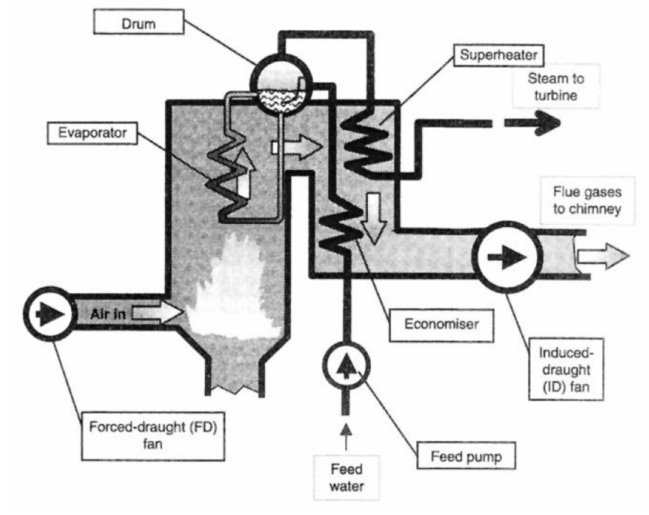
Figure 2. Schematic of a boiler